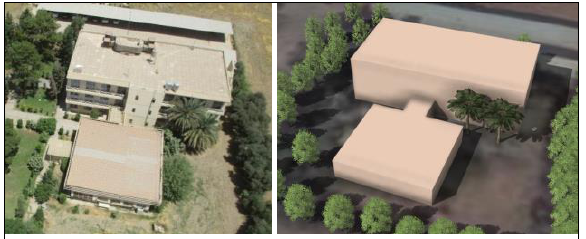
Figure 9. Left: UAV image captured from inclined view; right: image of same building produced from free satellite imagery, without textures and missing details